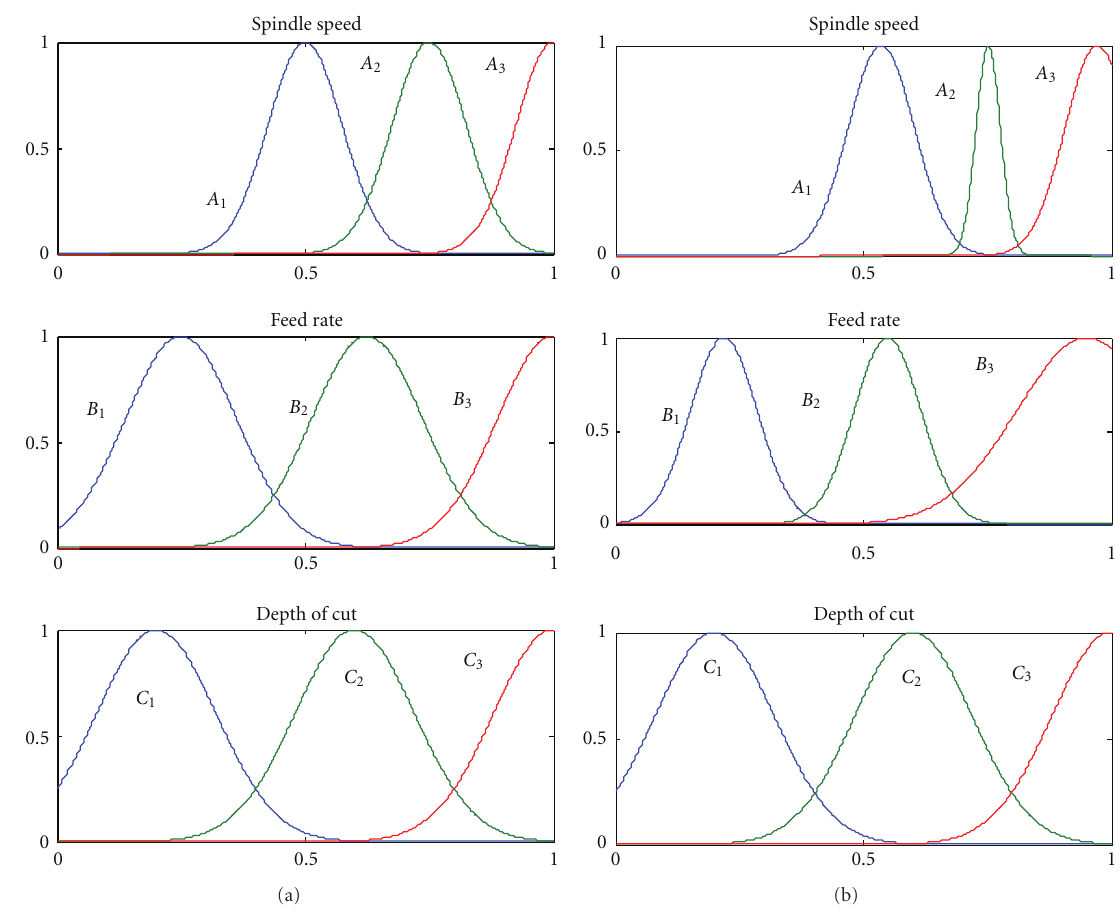
Figure 10: Membership functions of FO Sugeno model before training (a) and after training by ANFIS using HL